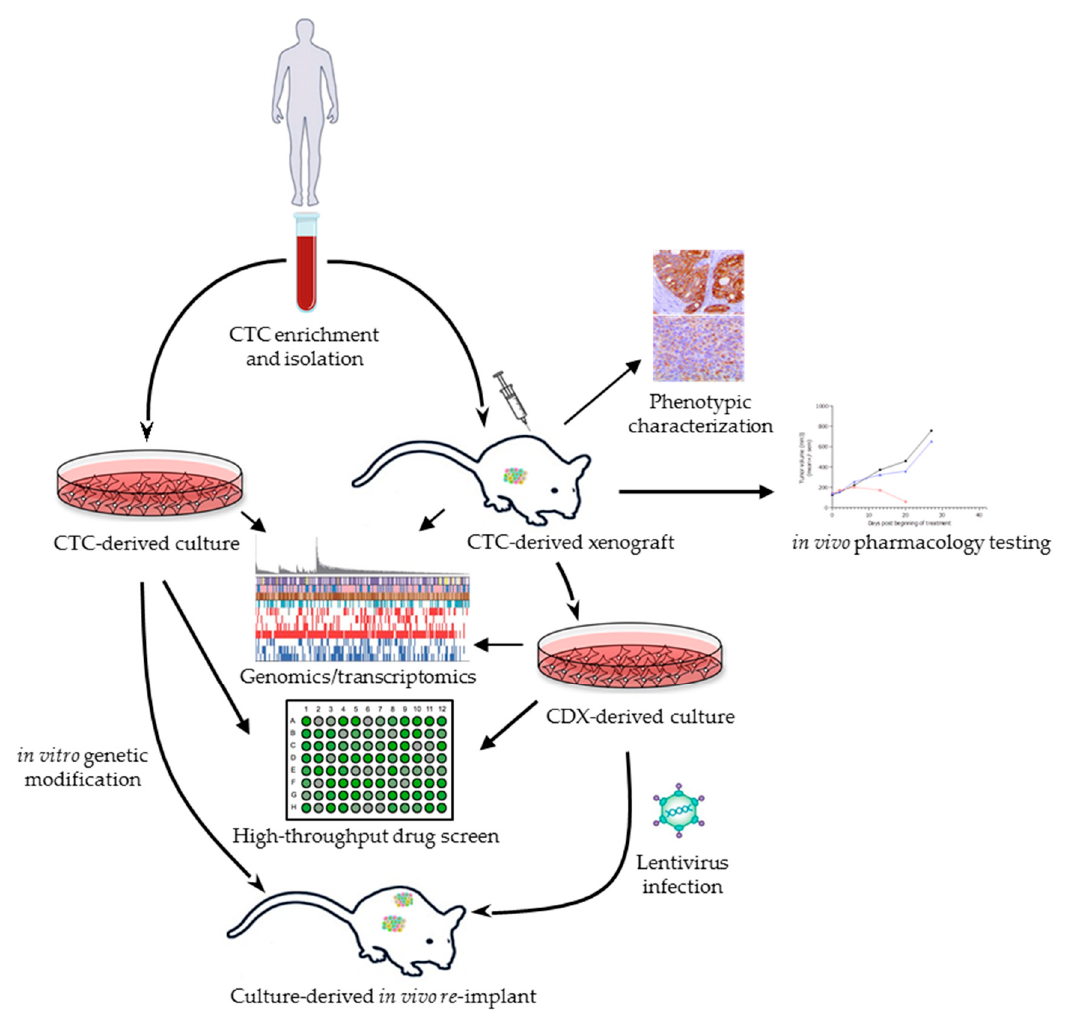
Figure 1. CTC-derived models as tractable systems to explore tumor-initiating cells (TICs) and new therapeutic strategies. CTCs isolated from late-stage cancer patients are used to generate CTC-derived xenografts (CDXs) to perform functional characterizations and pharmacology studies. CDX tumors can be isolated and dissociated into ex vivo cultures for drug screening and genome-wide analyses. CDX-derived cultures are amenable to lentiviral infection and can be re-injected into mice and used as tools to track tumor dissemination. In parallel, CTCs can be expanded in vitro and used as readouts of drug sensitivity. CTC = circulating tumor cell. CDX = CTC-derived xenograft.